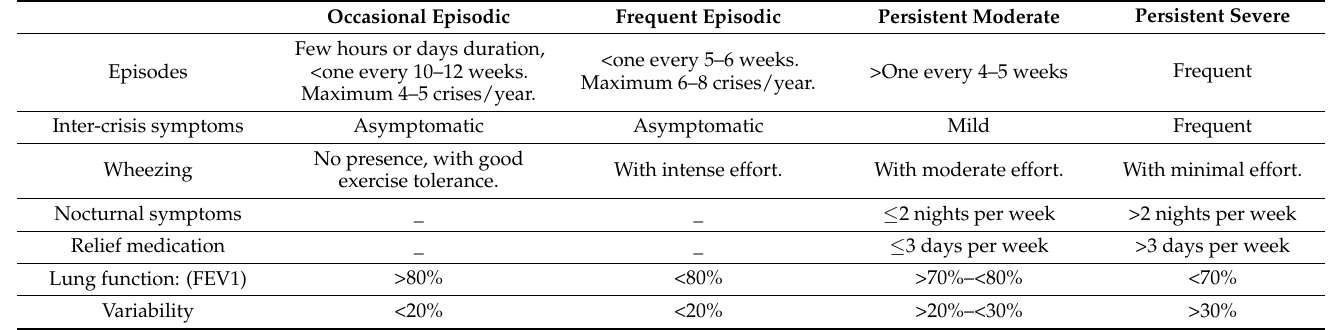
Table 1. Classification of asthma severity in children, according to